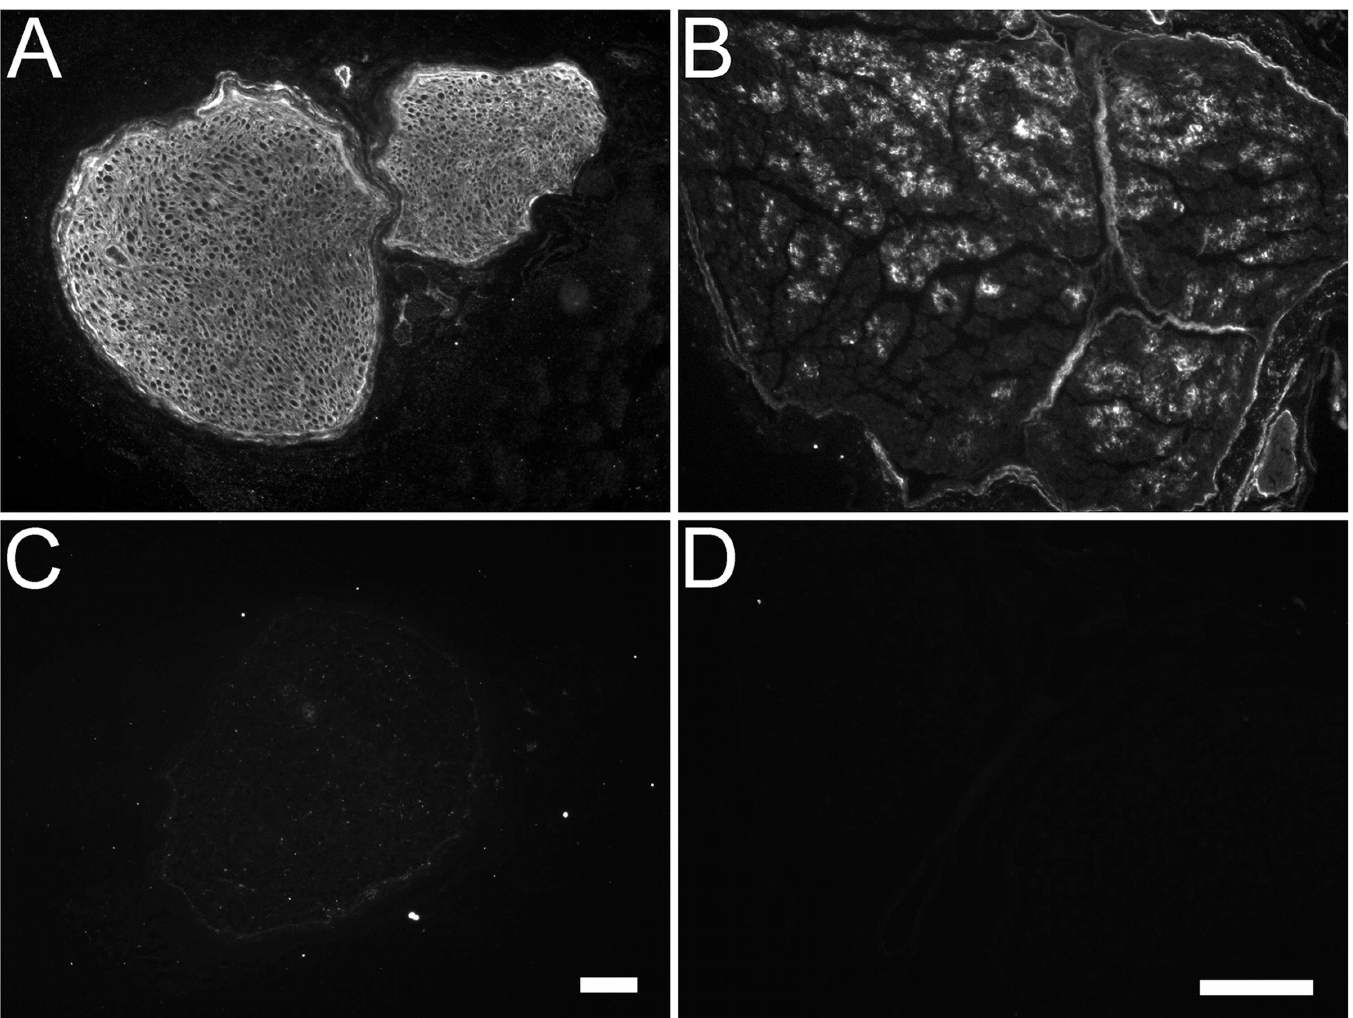
Fig 6. Chondroitinase C effectivelyremovedendoneurial chondroitin sulfate glycosaminoglycans. Normal human(A and C) and normalrabbit (B and D) were treated with chondroitinase C (C and D) and immunolabeled for CS-56 (A and C) or 473-HD(B and D). (A) CS-56 was present throughout the normal humannerve endoneurium. (B) 473-HDimmunolabeled a subset of endoneurial basal laminaetubes within the rabbit nerve. Chondroitinase C treatment effectively removed immunoreactivity of both CS-56 (C) and 473-HD(D) antibodieswhich indicatedthe glycosaminoglycanchains were cleavedoff the core protein. Scale bar: 100 μ m.